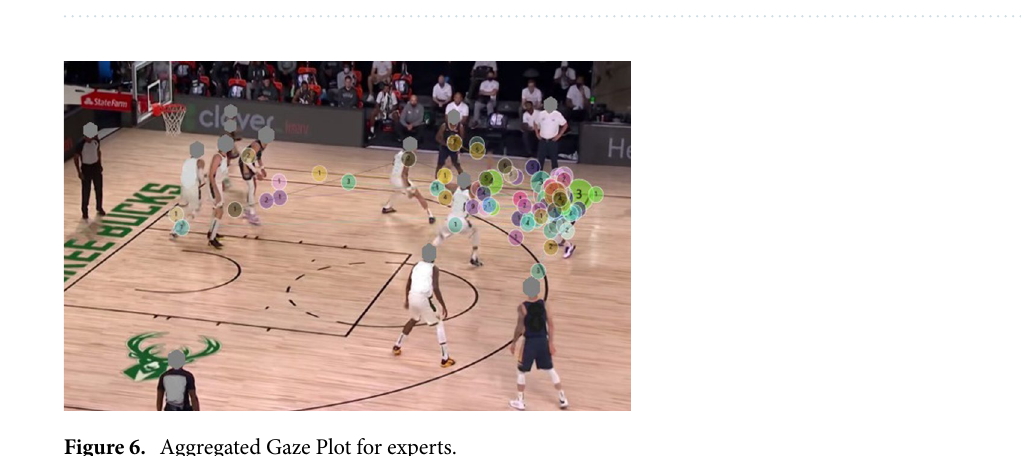
Figure 5. Comparison of the percentage of fixation counts in AOIs between groups.